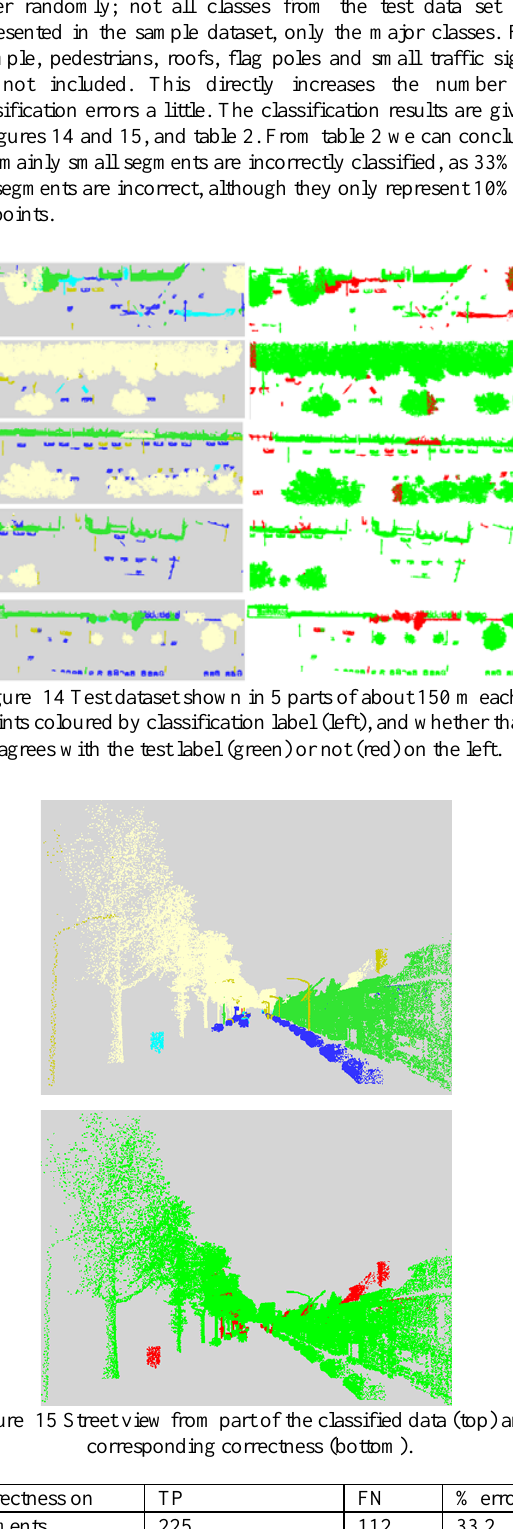
Figure 13 Two components on lamp posts overlaid using relative coordinates (left) and after ICP algorithm (right).